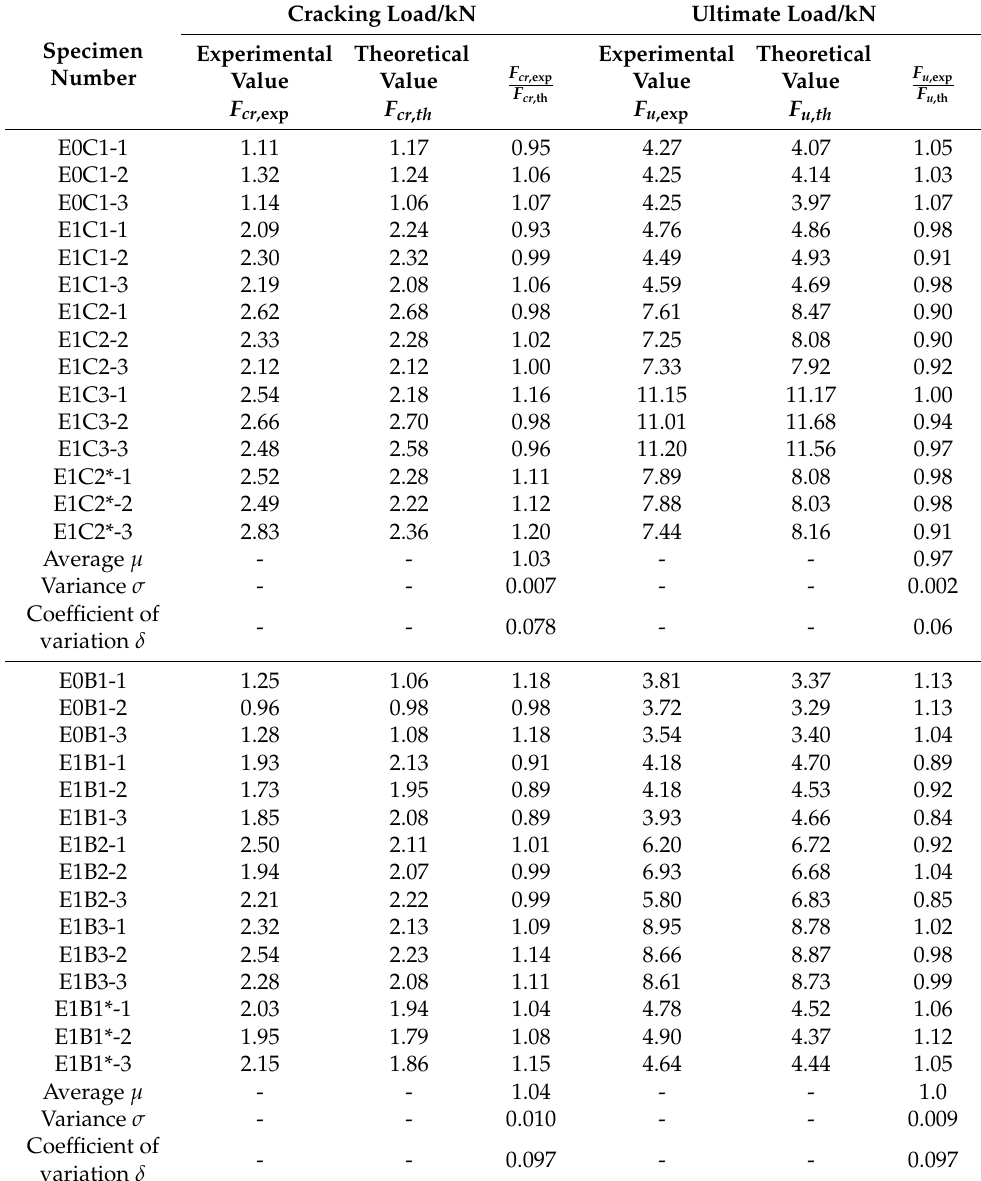
Table 6. Comparison of test and theoretical values of FRP grid-reinforced ECC composite specimen load characteristic